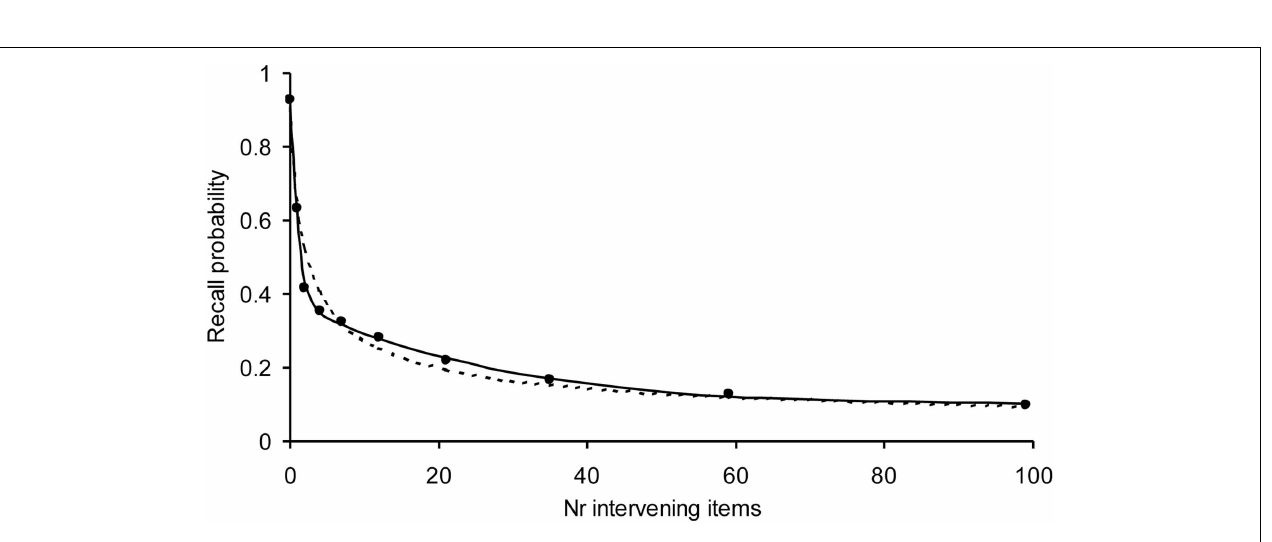
(1999). Each data point is based on 1800 observations.The model fitted well on the chi-square test, which becomes more severe with the number of observations ( α = 0.55 and R 2 > 0.999).The power-law was rejected by the chi-square